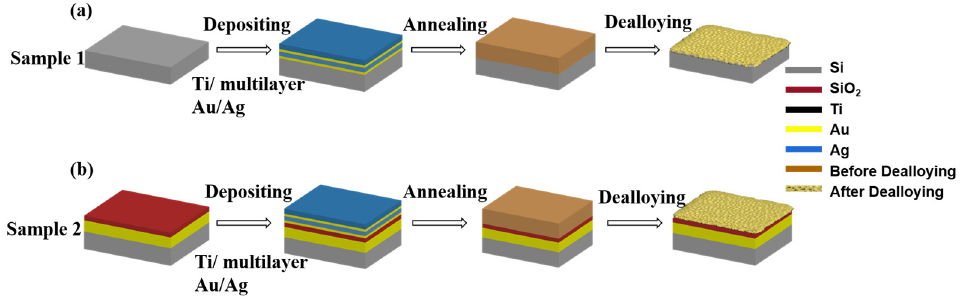
Figure 1. Schematic of the fabrication processes for ( a ) the porous Au–Ag structure and ( b ) the po- rous Au–Ag structure with bo tt om Au mirror by depositing, annealing, and dealloying techniques. Au–Ag structure with bottom Au mirror by depositing, annealing, and dealloying